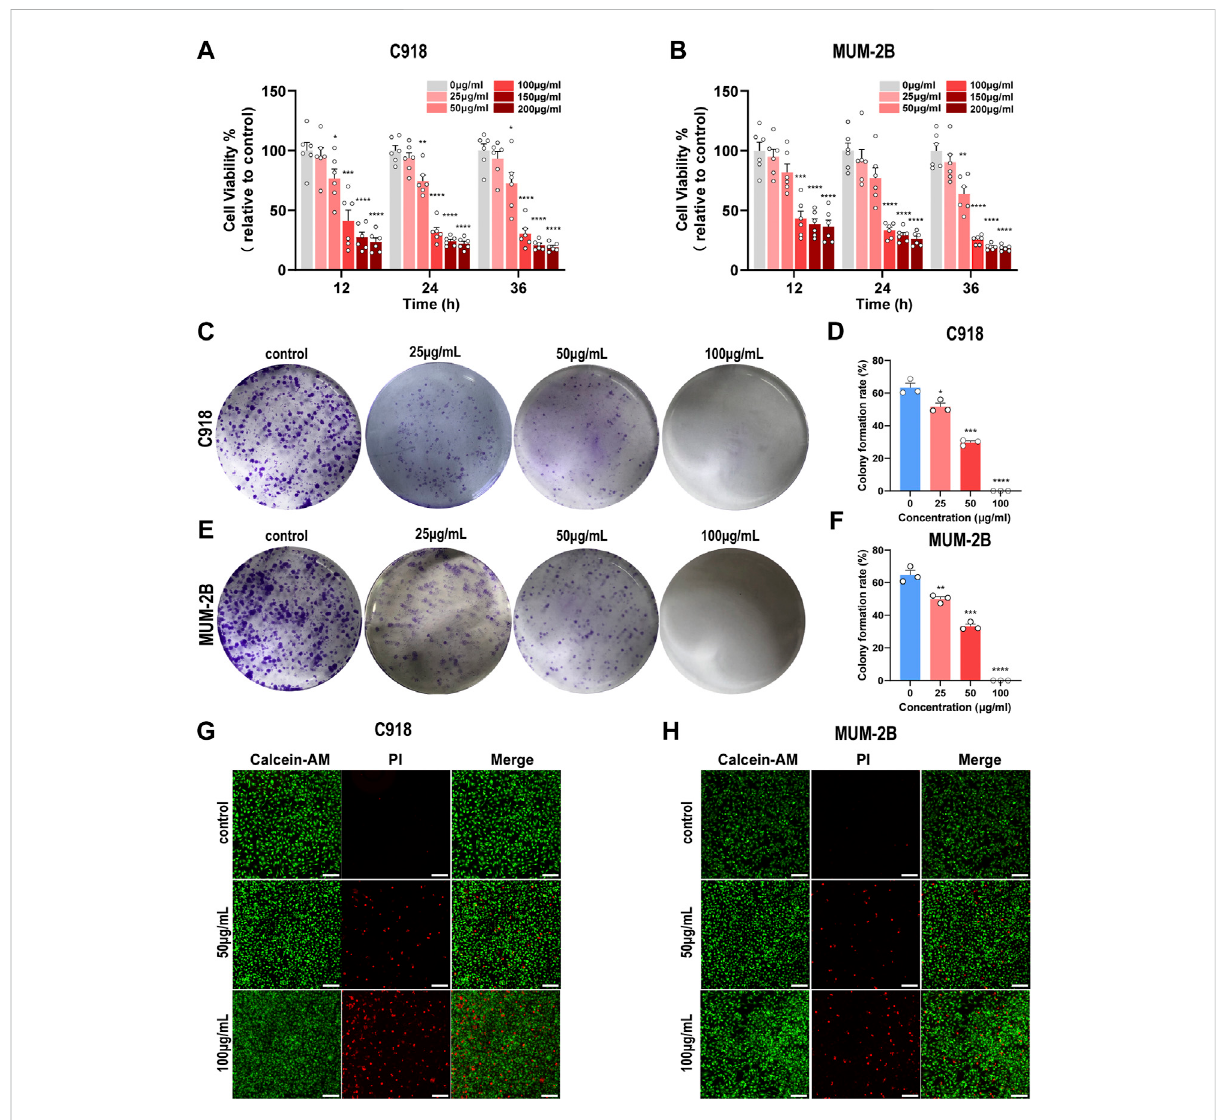
FIGURE 3 NMQDs-Ti 3 C 2 TxinhibitsUMcellproliferationandcloneformation (AandB) TheCCK-8assayofC918andMum-2Bcellsculturedwithdifferent concentrations of NMQDs-Ti 3 C 2 Tx for 12, 24, and 36 h (n = 6; * p < 0.05, ** p < 0.005, *** p < 0.0005, **** p < 0.0001) (C and E) Colony formation assay results. C918 and Mum-2B UM cells were cultured with differentconcentrations ofNMQDs-Ti 3 C 2 Tx for 12 days (Dand F) The clone formation rate results were counted according to the graph C and E (n = 3; * p < 0.05, ** p < 0.005, *** p < 0.0005, **** p < 0.0001). (G and H) Live/dead stainingresults.ThelivecellswerestainedwithCalcein-AM,andthedeadcellswerestainedwithPI.Scalebar:200 μ m.Allabovedataarepresented as the mean ±